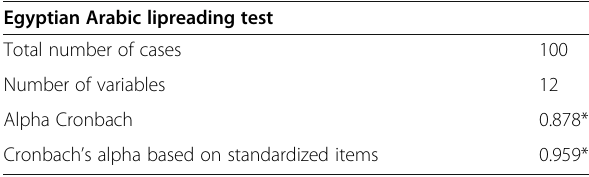
Table 7 The alpha Cronbach for test-retest reliability analysis of the used tool the “ Arabic lipreading test ”